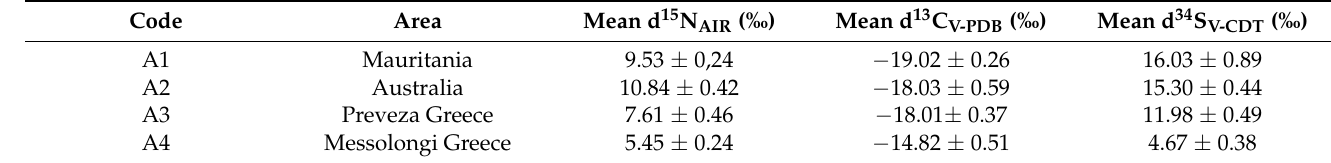
Figure 2. Greek Bottarga (Fish—Roe) from Messolongi—Aitoliko Lake Registered ‘Avgotaracho Messolongiou’ PDO. Table 1. Bottarga analysis results (mean δ values and s.d.).